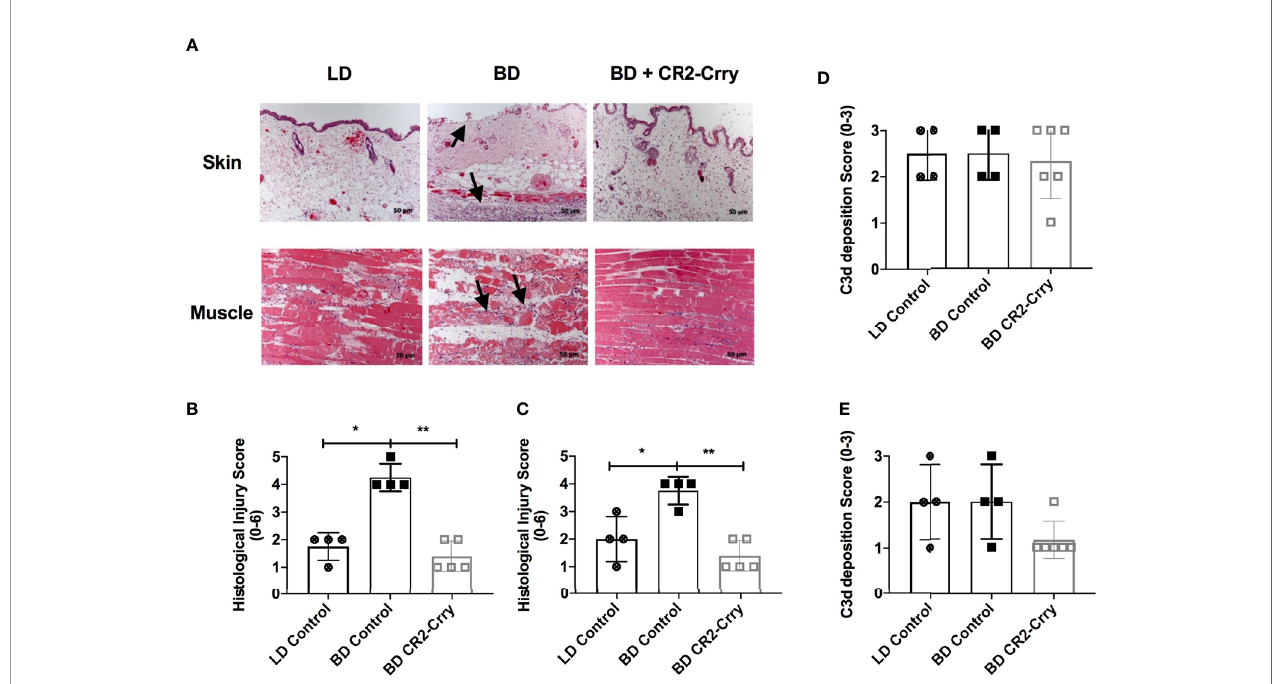
FIGURE 4 | Donor graft treatment with CR2-Crry reduces histological evidence of graft injury in VCAs at 48 hours post-Tx. (A) Histological sections of skin and muscle graft tissue collected 48 hours post transplantation and stained with H&E. Sections were assessed for injury using a semi-quantitative histopathological score by blinded observer. Note the immune in fi ltrates in the muscle and skin, and associated muscle and epithelial injury seen in BD (arrows) as compared to LD and BD+CR2-Crry. Pairwise comparison for both skin (B) and muscle (C) between LD vs BD (*p < 0.01), and BD vs BD+CR2-Crry (**p < 0.01); differences between LD vs BD+CR2-Crry were not signi fi cantly different. Quanti fi cation of C3d deposition measured by immunohistochemistry staining of skin (D) and muscle (E) VCA graft tissues sections. No signi fi cant difference in C3d deposition could be determined at 48 hrs post